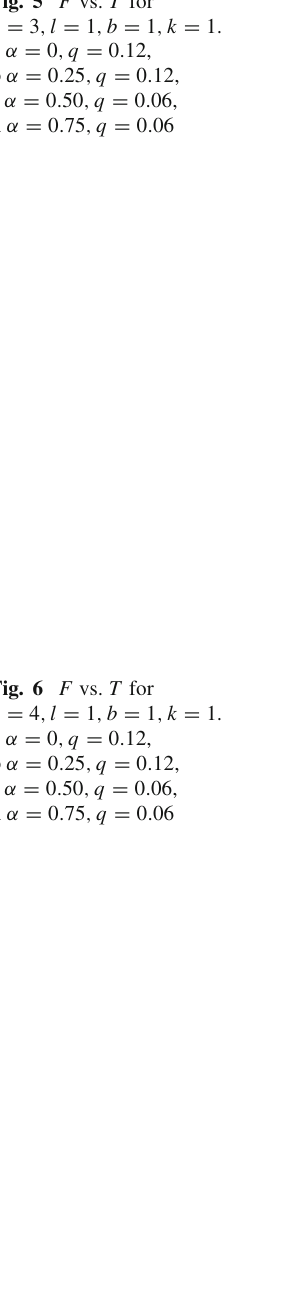
Fig. 5 F vs. T for n = 3 , l = 1 , b = 1 , k = 1. a α = 0 , q = 0 . 12, b α = 0 . 25 , q = 0 . 12, c α = 0 . 50 , q = 0 . 06, d α = 0 . 75 , q = 0 . 06